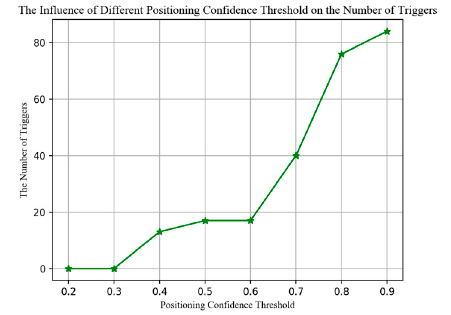
Sensors 2020 , 20 , x FOR PEER REVIEW Figure 9. The influence of different floor positioning confidence threshold on the number of triggers. Figure 9. The influence of di ff erent floor positioning confidence threshold on the number of triggers.